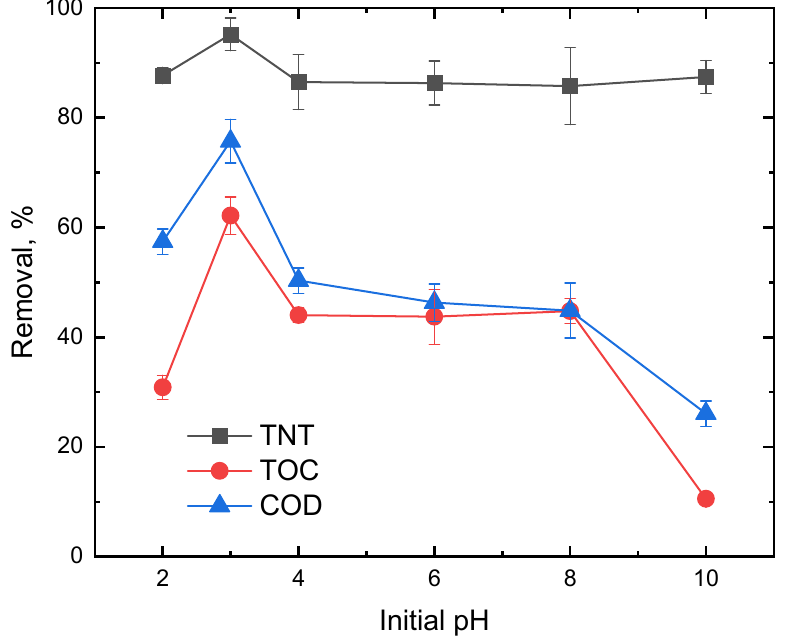
Figure 2. Effect of pH on TNT, TOC and COD removals. Experimental conditions: (TNT) 0 = 30 mg/L, (Fe 2+ ) = 5 × 10 − 4 M, (H 2 O 2 ) = 5 × 10 − 3 M, (NaCl) = 10 − 2 M, US intensity = 8571 W/m 3 , Temperature = 25 °C, Reaction time = 60 min.